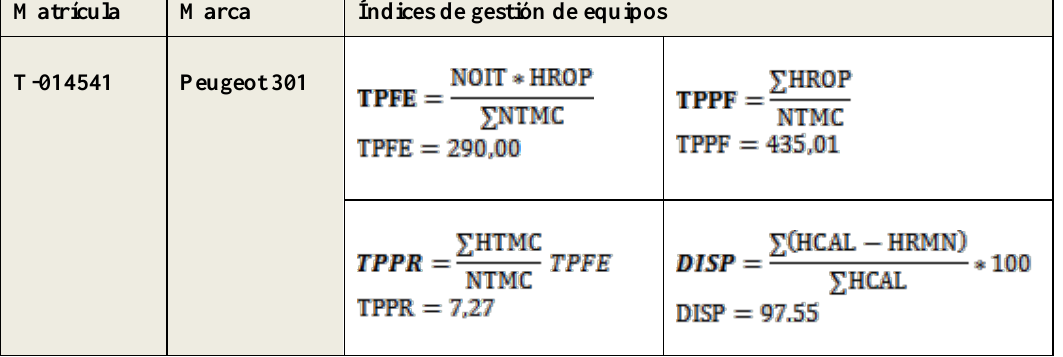
Fuente: Los autores,